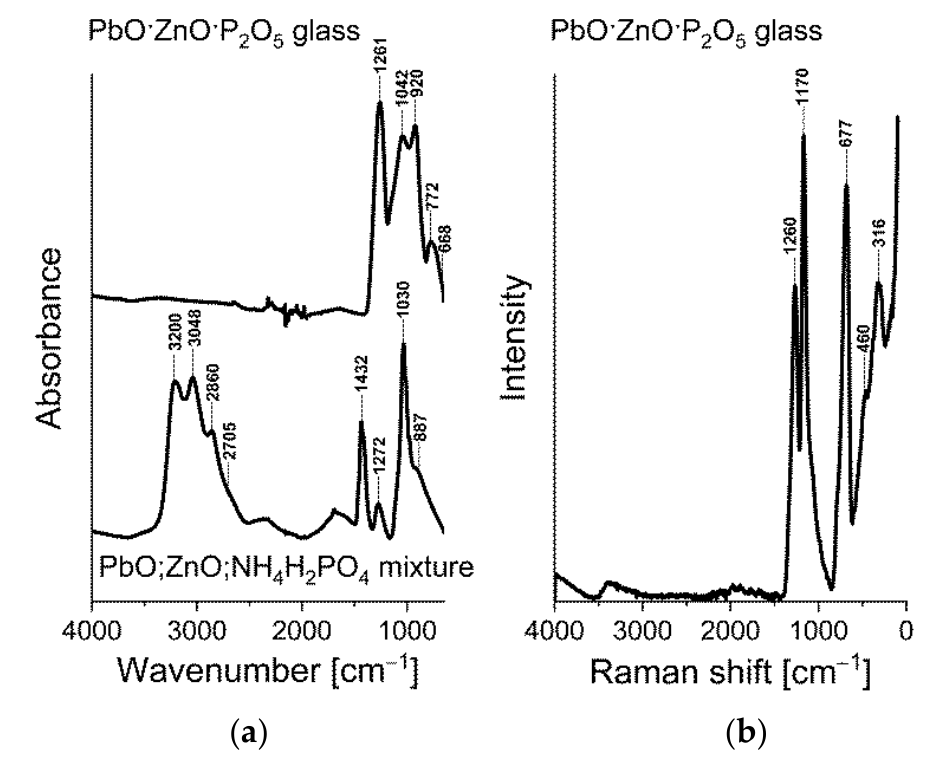
Figure 1. FTIR ( a ) and FT-Raman ( b ) spectra for PbO · ZnO · P 2 O 5 glass. Reprinted with permission from [35]. 2020, Czech Chemical Society.